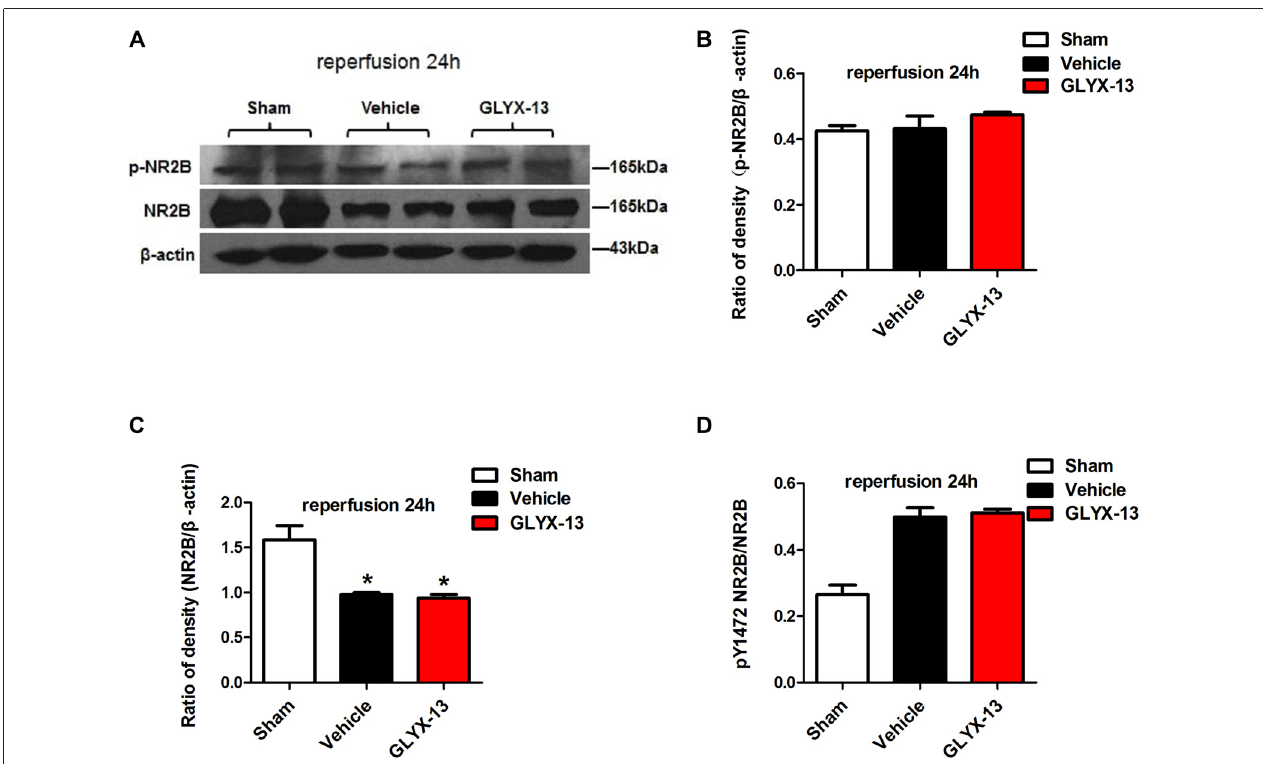
FIGURE 8 | GLYX-13 has no effect on the loss of NR2B after 24 h reperfusion. (A) Representative images of western blot. The intensity of each band was quantified by image j and normalized in relation to β -actin. (B–D) Statistical analysis of densitometric data from indicated experimental groups. The values are expressed as mean ± SEM, n = 3 independent experiments. One-way ANOVA and Newman-Keuls post test ∗ p < 0.05, vs.